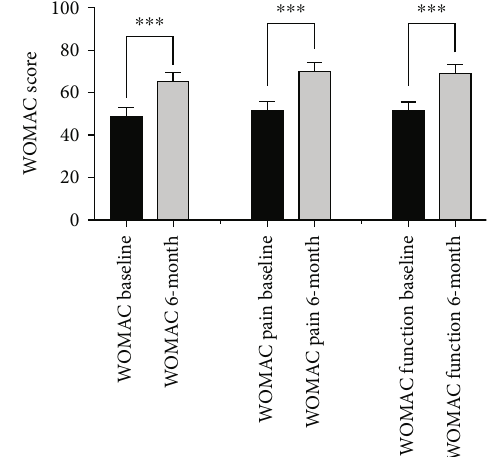
Figure 2: WOMAC scores at baseline and at six months postprocedure. The overall WOMAC scores were signi fi cantly improved at 6 months as compared to baseline. In addition, both the WOMAC pain and functional subscales were signi fi cantly improved at 6 months over baseline ( ∗∗∗ p ≤ 0 : 0001 ). women ( 44 : 7 ± 5 : 25 to 64 : 2 ± 5 : 75 , p < 0 : 0001 , and n = 53 ), patients ≥ 65 years of age ( 49 : 1 ± 6 : 13 to 65 : 4 ± 5 : 56 , p < 0 : 0001 , and n = 49 ), and patients < 65 years of age ( 49 : 2 ± 5 : 54 to 67 : 4 ± 5 : 89 , p < 0 : 0001 , and n = 46 ). There were no